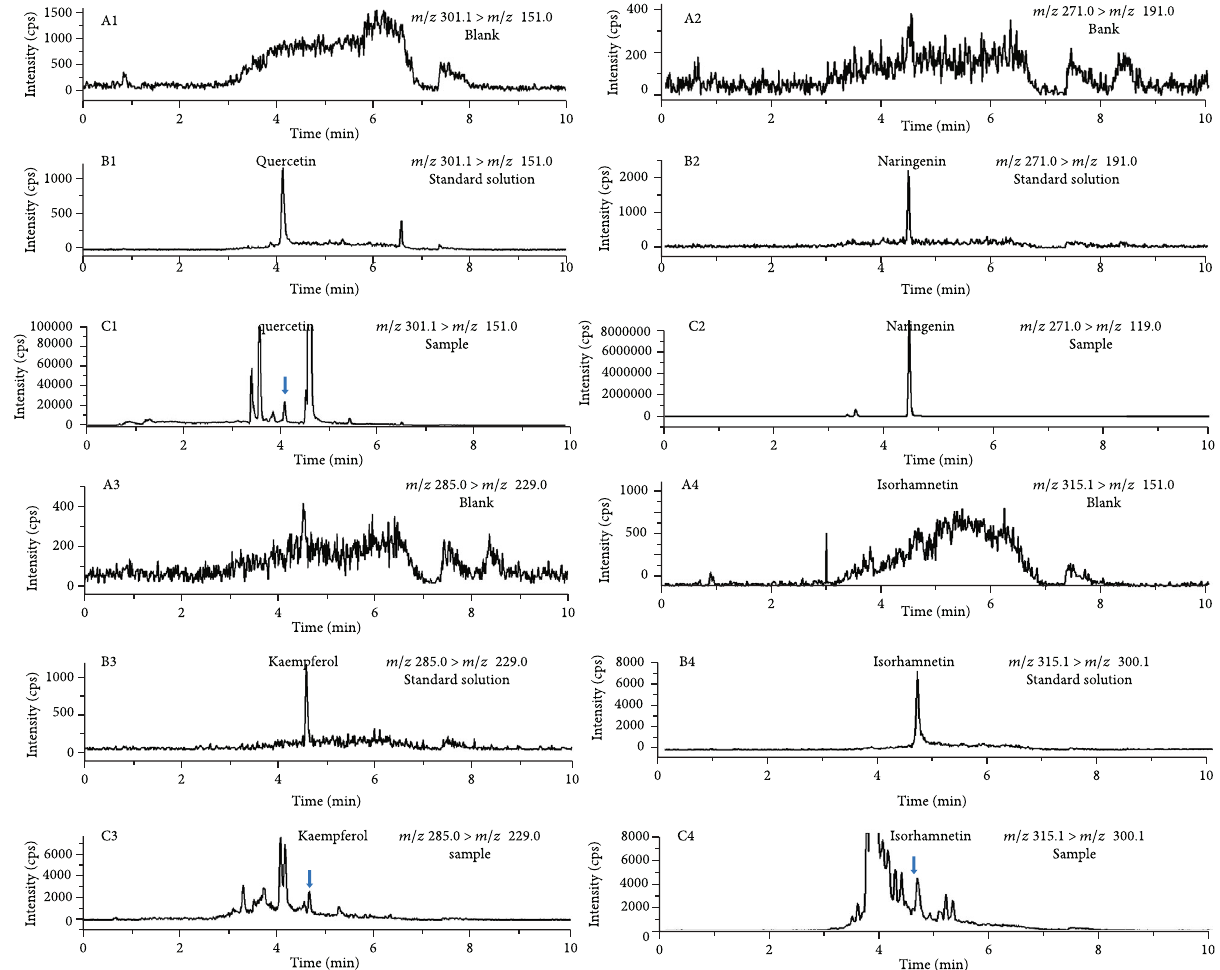
Figure 12: The TIC chromatographs of quercetin, naringenin, kaempferol, and isorhamnetin in blank solution (A1 – A4), standard solution spiked at limit of quantitation (B1: 0.01ng/mL, B2: 0.005 ng/mL, B3: 0.2ng/mL, and B4: 0.01ng/mL) and sample solution (C1 –